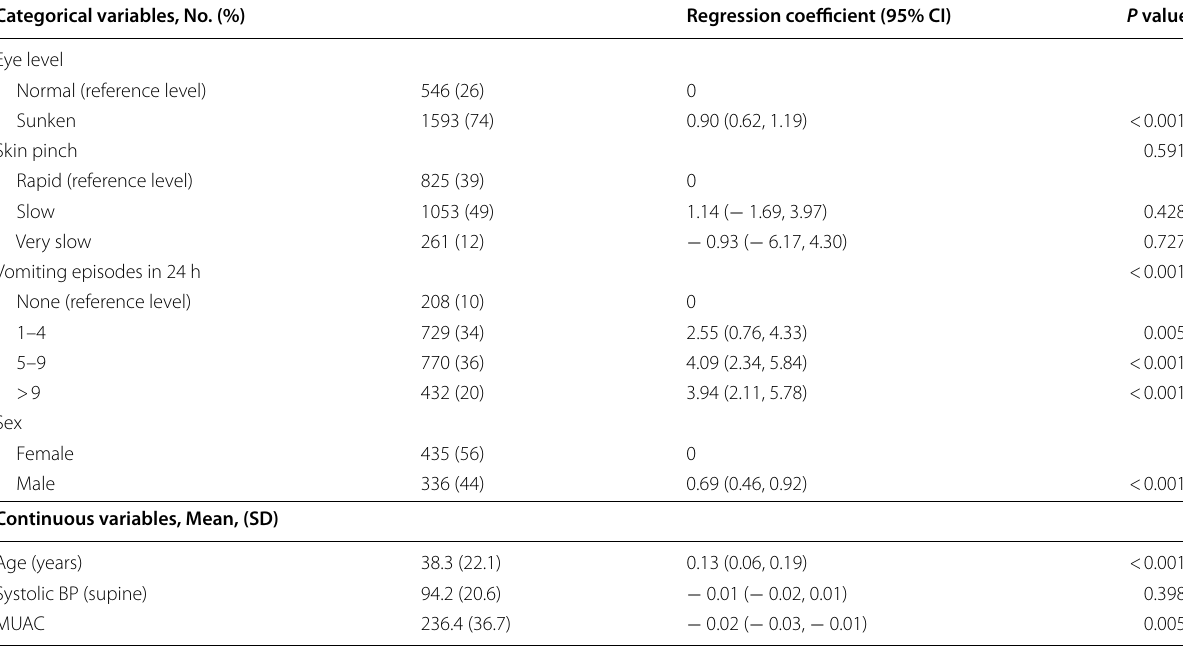
Table 4 Predictors and regression coefficients in the NIRUDAK model Categorical variables, No.